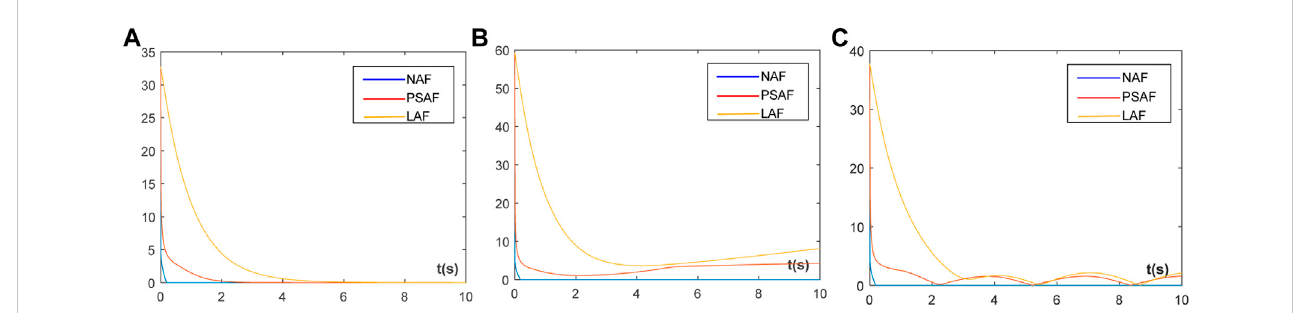
FIGURE 4 Residual graphs generated by the three activation function: (A) Simulated residual errors of ZNN for solving TDSE without noise; (B) Simulated residual errors of ZNN for solving TDSE with y(t) = 0.3t; (C) Simulated residual errors of ZNN for solving TDSE with y(t) = cos(t).